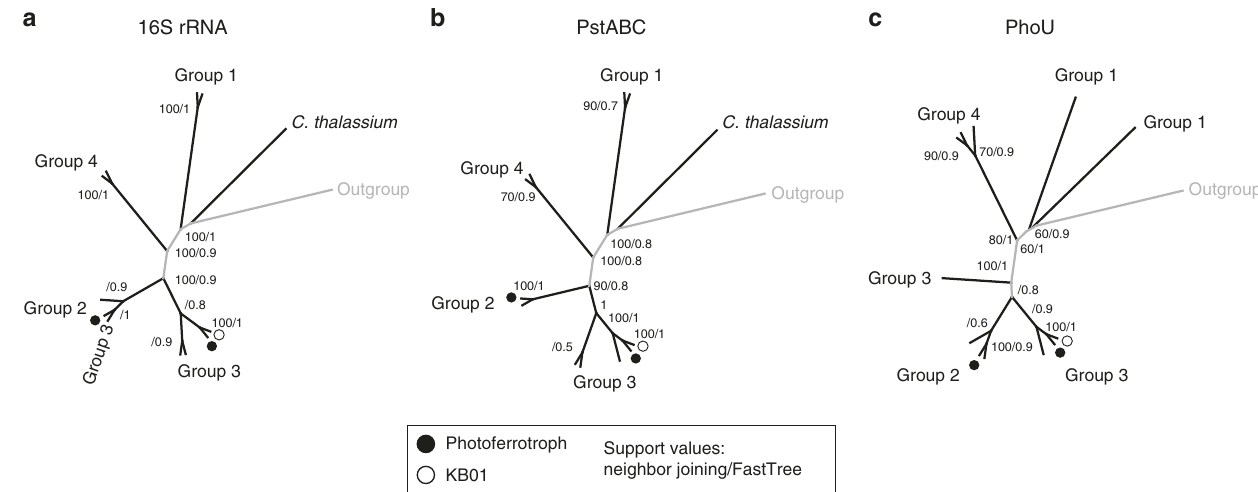
Fig. 3 Comparative molecular phylogeny of 16S rRNA and major genes regulating P metabolism. Approximately Maximum-Likelihood Trees (FastTree) of concatenated 16S rRNA gene ( a ), PstABC ( b ), and PhoU ( c ). Nodes are annotated with Neighbor Joining (1000x bootstrapped) and FastTree support values. These phylogenies are equivalent to previously established and accepted phylogenies for the Chlorobiales based on the 16S and FMO genes. Maximum likelihood and maximum parsimony yielded trees with similar topology (trees not shown). Clade nomenclature follows recommended taxonomy: Group 1 = Prostheochloris , Group 2 = Chlorobium 2, Group 3 = Chlorobium 3, Group 4 = Chlorobaculum . The outgroup is Rhodothermus marinus DSM 4252. Circles at the branch tips represent photoferrotrophic organisms and the ( ○ ) denotes Chlorobium phaeoferrooxidans strain KB01. Note that C . thalassium